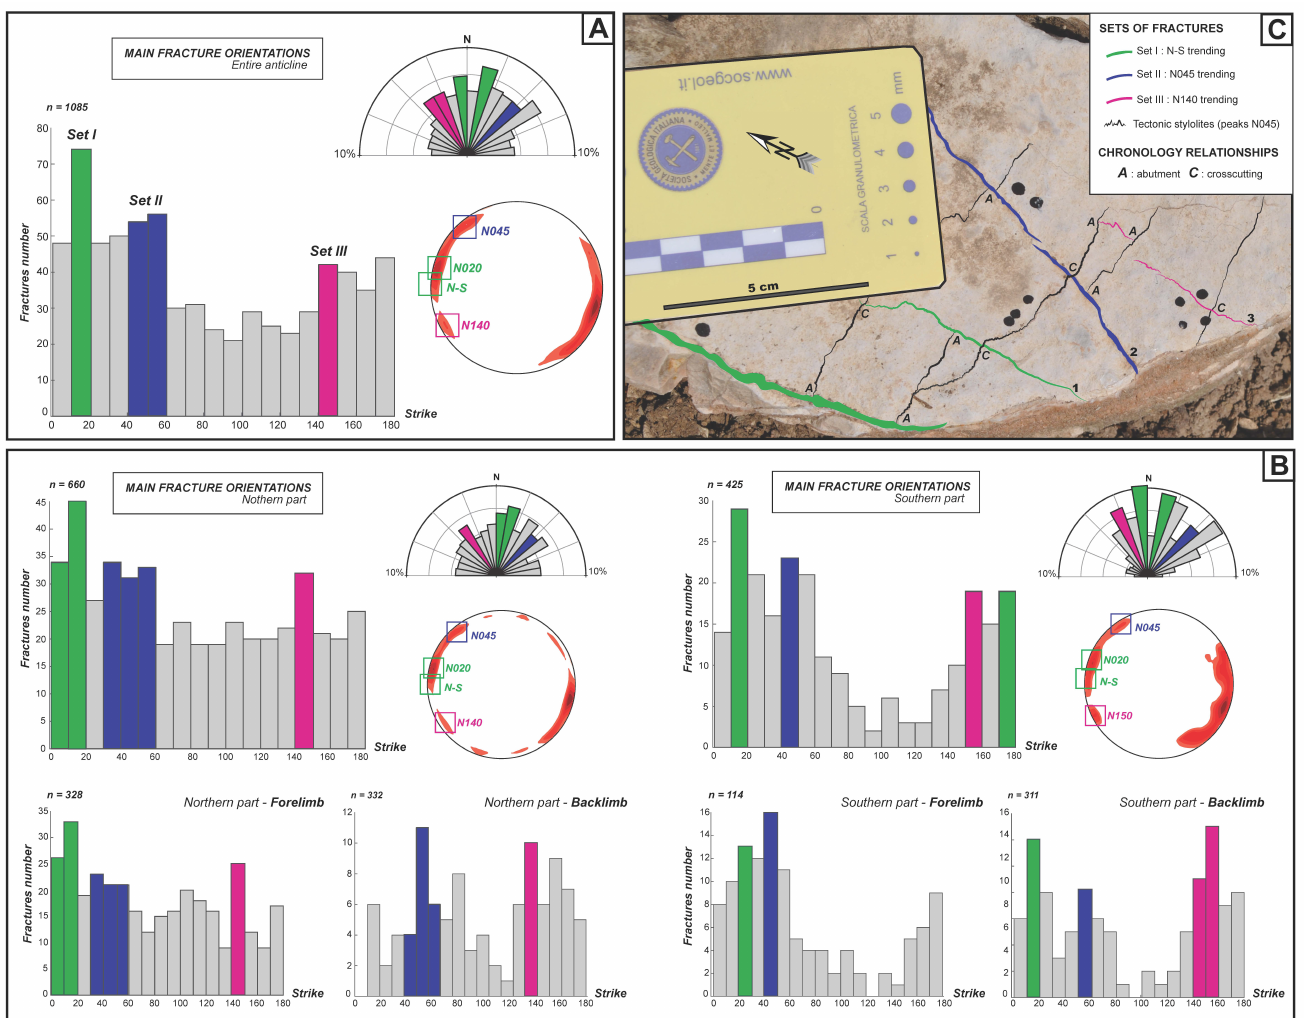
Figure 4. Main fractures orientations (after unfolding) plotted on histograms, stereograms and rose diagrams for ( A ) the whole anticline and ( B ) northern and southern parts of the anticline, discriminating forelimb and backlimb measurements. Three major sets of fractures discriminated according these orientations are represented with their specific color (green: set I, blue: set II, pink: set III). ( C ) Chronological relationships between fractures and stylolites (i.e., abutment and crosscutting), observed at mesoscopic